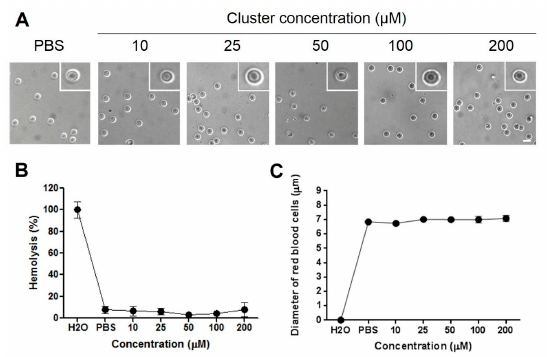
Figure 3. Hemolysis and morphology of human red blood cells after acute exposition (0 h) to increasing concentrations of the cluster. ( A ) Representative pictures of red blood cells at different cluster concentrations are shown. Exposition to 200 µM of the cluster induces slight crenation of red blood cells, compared to controls; ( B ) Hemolysis was similar to control (phosphate buffered saline (PBS)) through all concentrations; ( C ) The average size of erythrocytes is similar in all concentrations. Scale bar: 10 µm.